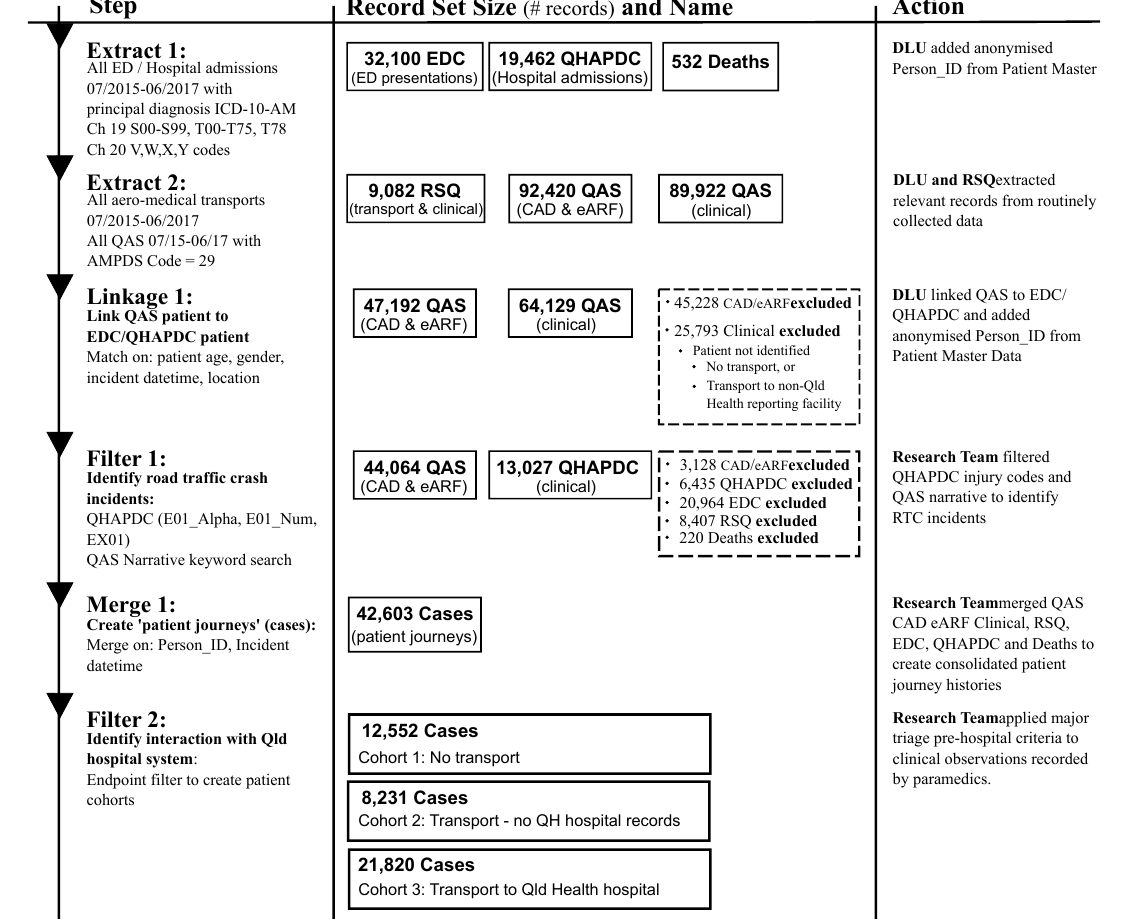
Figure 1. Event log generation—from source data to main analysis